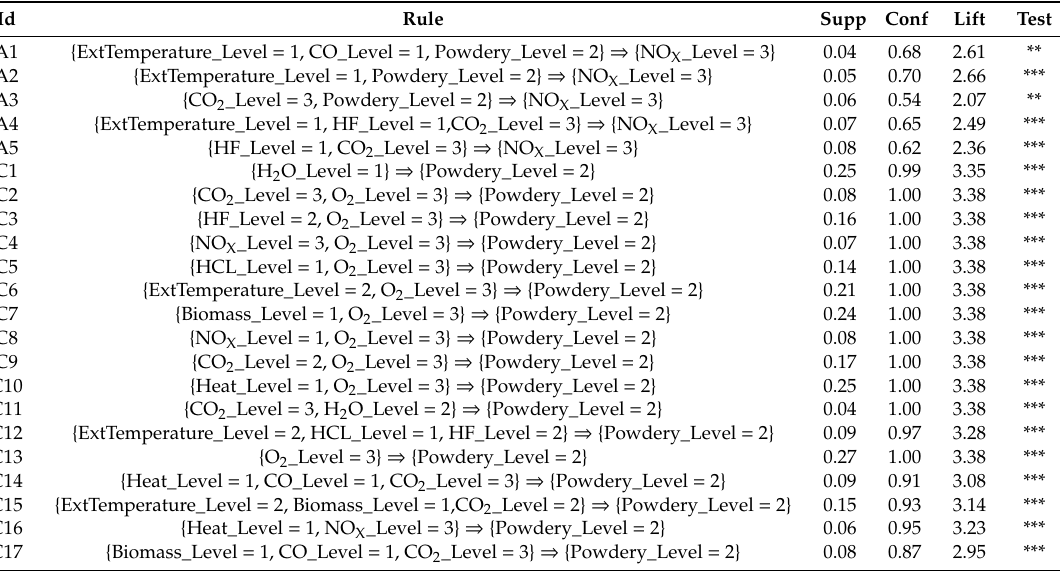
Table 3. Evaluation results for candidate